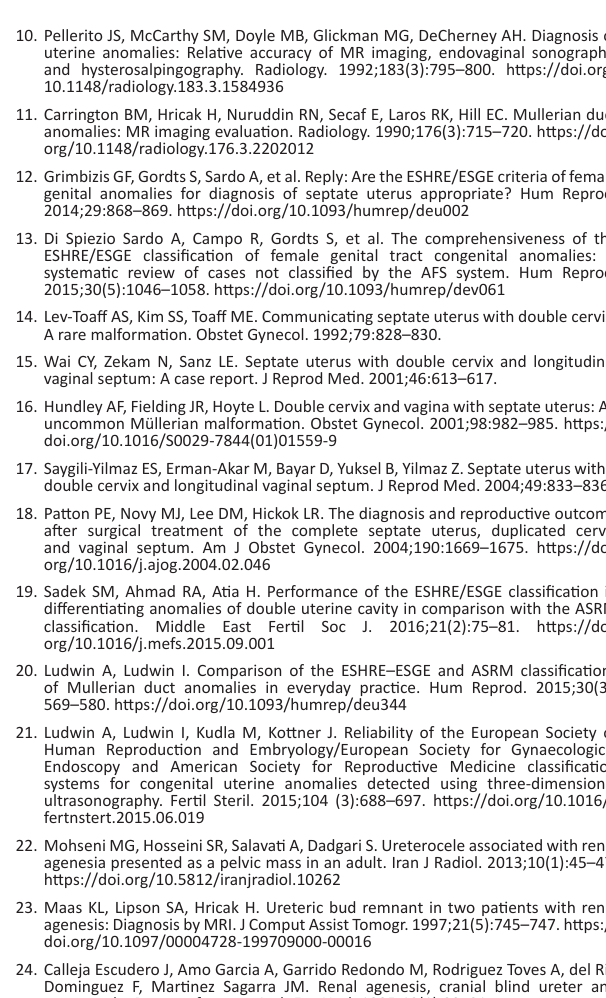
FIGURE 18 (a and b): Sagittal T2 sequence demonstrates the uterus and cervix distended with haematometra with a thick non-canalised inferior margin of the